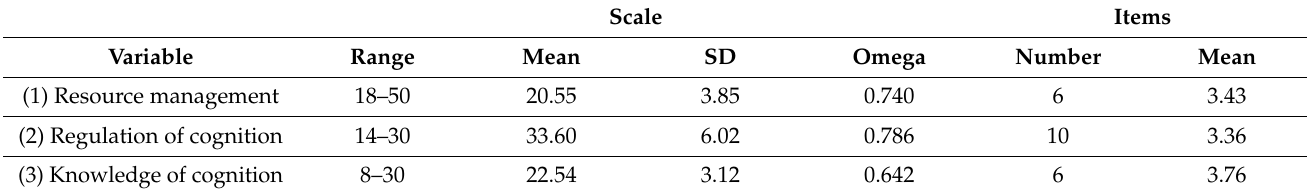
Table 2. Means, standard deviations, and internal consistency of SRL